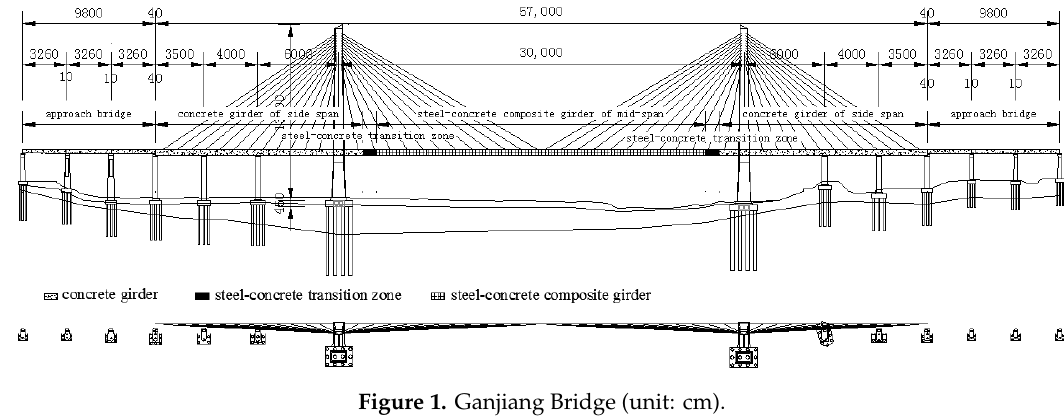
Figure 1. Ganjiang Bridge (unit: cm).